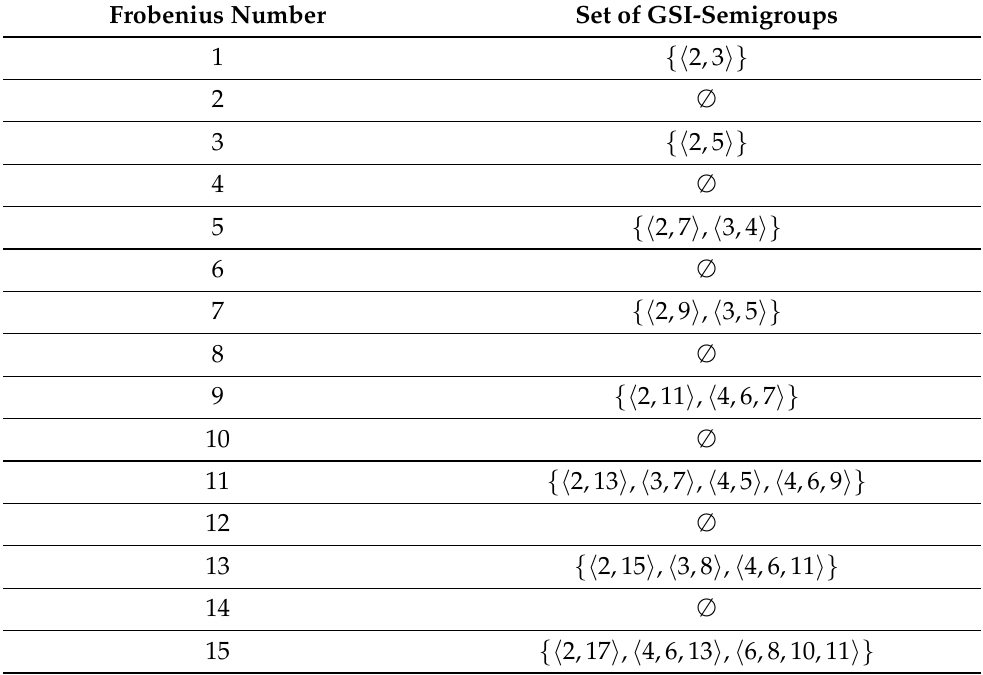
Table 1. Sets of GSI-semigroups with Frobenius number up to